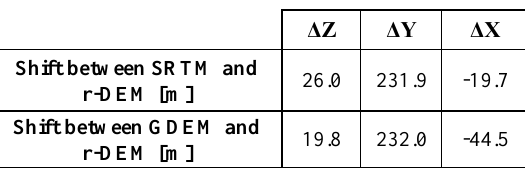
Table 2. Shift values between r-DEM and global DEMs The X and Y coordinate differences between SRTM and r-DEM